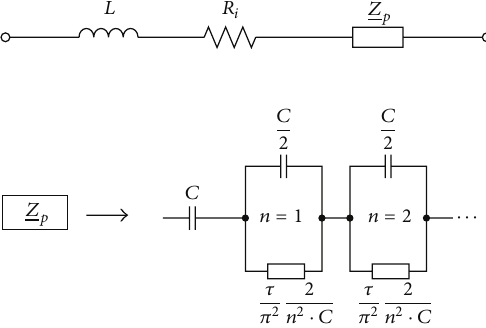
Figure 4: Equivalent circuit developed by Buller et